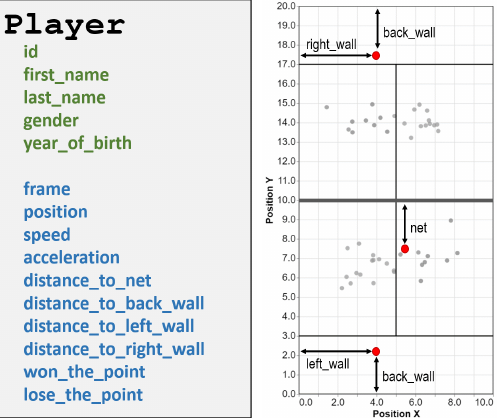
Figure 10. Left: Main methods of the Player class. The methods in green are available for any Player object, whereas those in blue are available only for Player instances bound to a particular Frame. Right: Reference system for players’ positions and